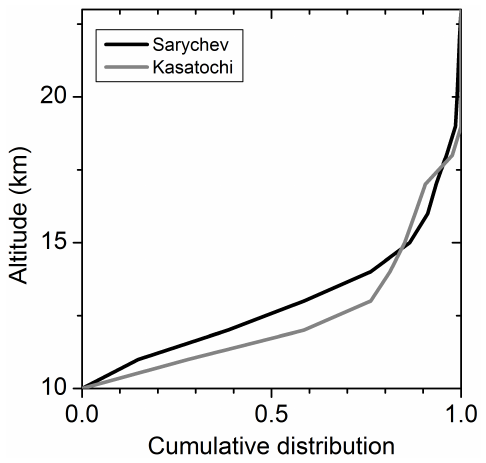
Fig. 7. Mass ratio of iron to sulphur in aerosol samples influenced by three volcanoes (marked by different symbols) vs. time since the start of the eruptions. The line shows a fit to the Fe/S ratio for the samples influenced by the Sarychev and Kasatochi eruptions. Samples shown with open symbols have been excluded from the